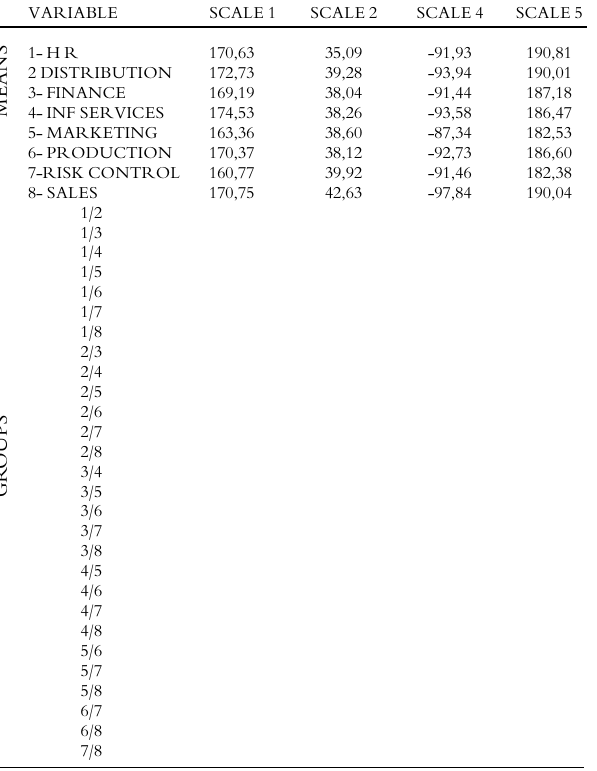
TABLE14 DUNNETT’S POST-HOCMULTIPLECOMPARISONS: COMPARISONOF THEMEANSOFTHEVARIOUS’’FUNCTIONALDISCIPLINES’’INRESPECT OF SCALES3 AND 6 OF